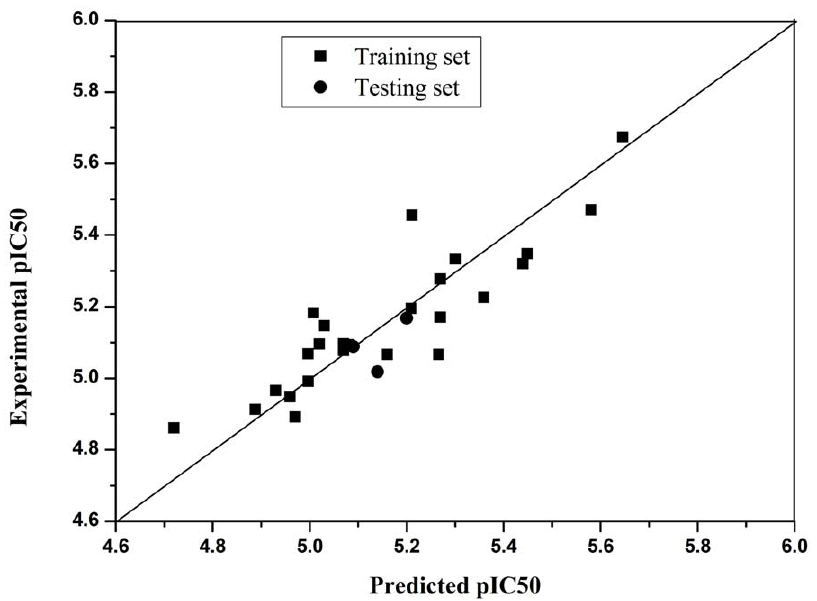
Figure 3. Correlation between predicted activities (IC 50 ) by QSARs models and the experimental activities (IC 50 ) (for compounds of training set, R 2 =0.787; for randomly selected compounds 9b,11b,14c as testing set, Residue are 0.03176; 0.1224, 0.00163. Correlation is significant at the 0.01 level.).